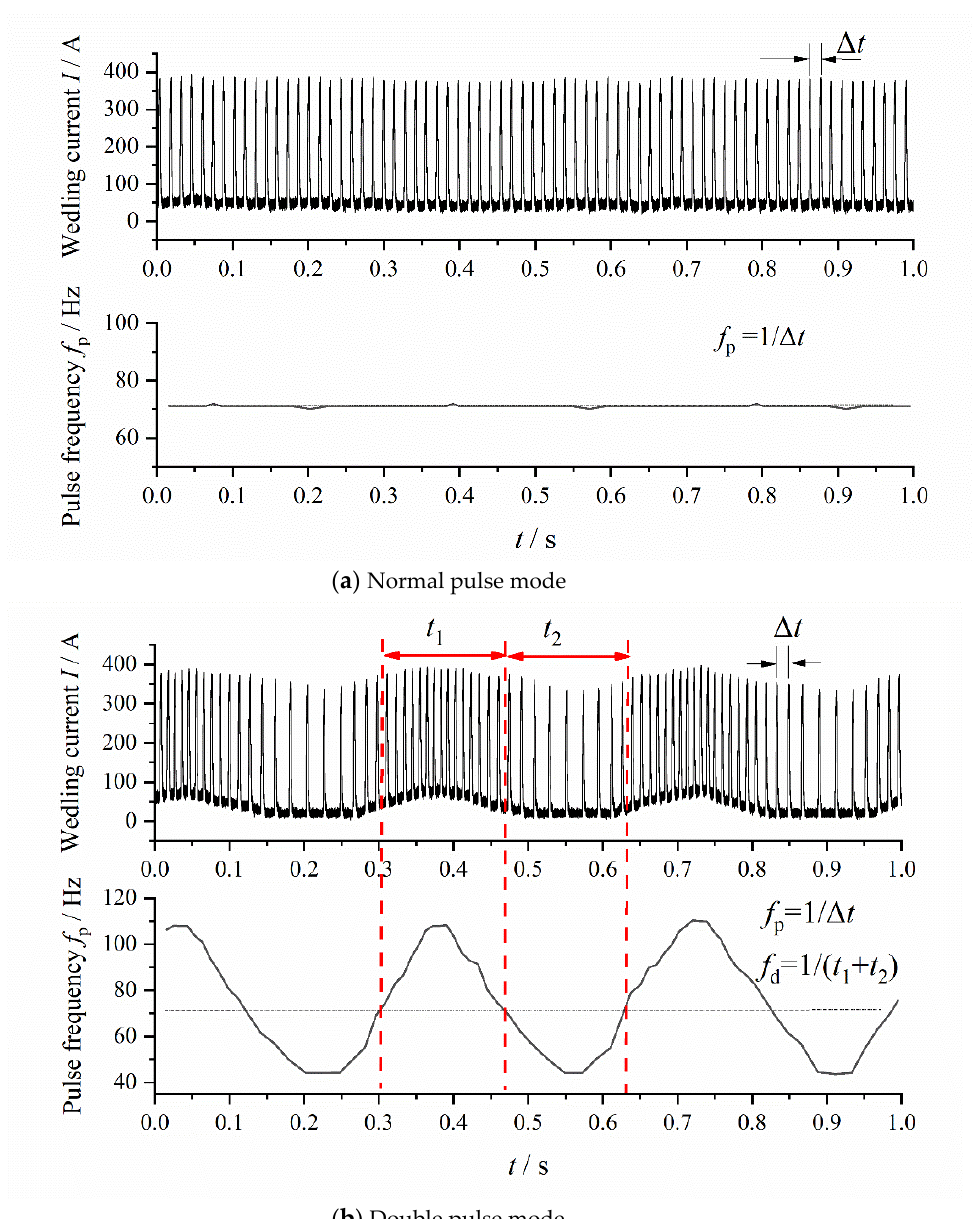
Figure 3. Electrical signal characteristics of normal-pulse mode and double-pulse mode.